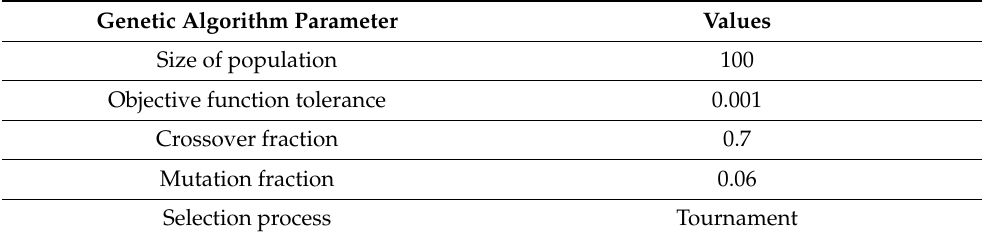
Table 8. Parameters of genetic algorithm.